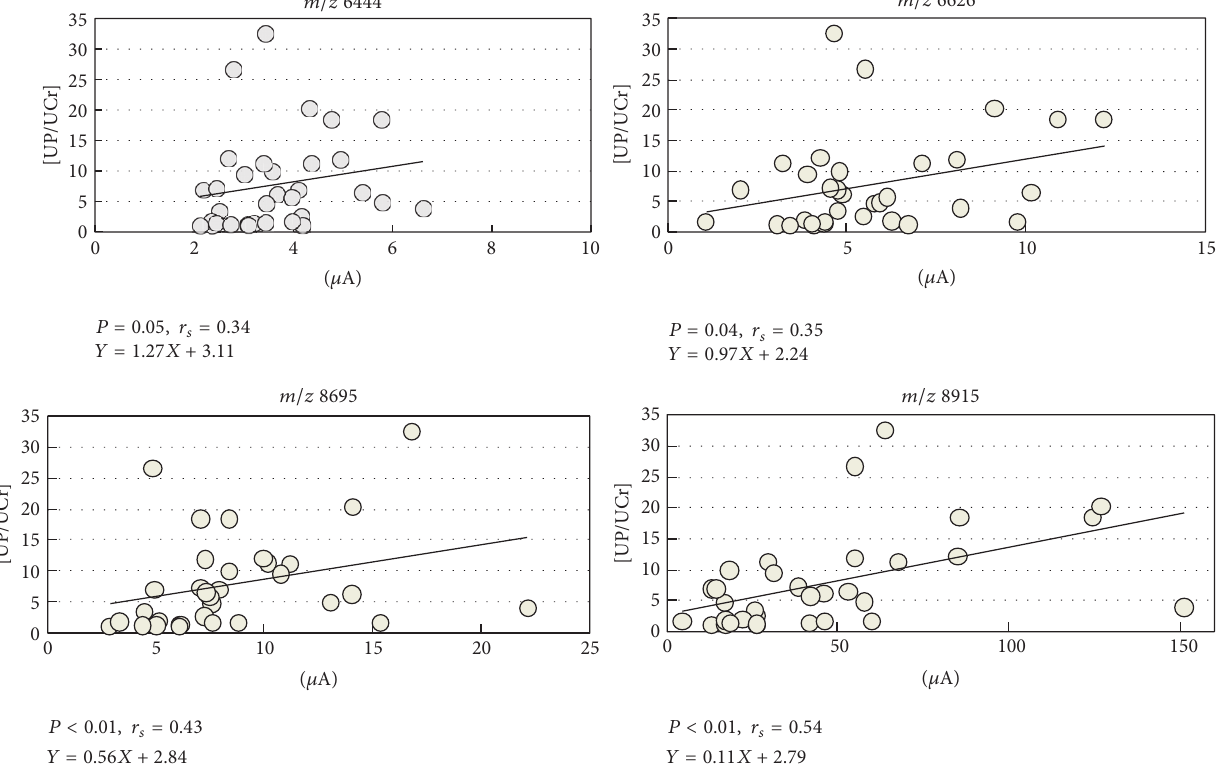
Figure 3: Correlations between the intensities of each mass-to-charge ratio ( m/z ) and each urinary protein/urinary creatinine (UP/UCr) ratio. Significant correlations were found between the intensities of the peaks at m/z ratios 6,626, 8,695, and 8,915 and their UP/UCr ratio [7].